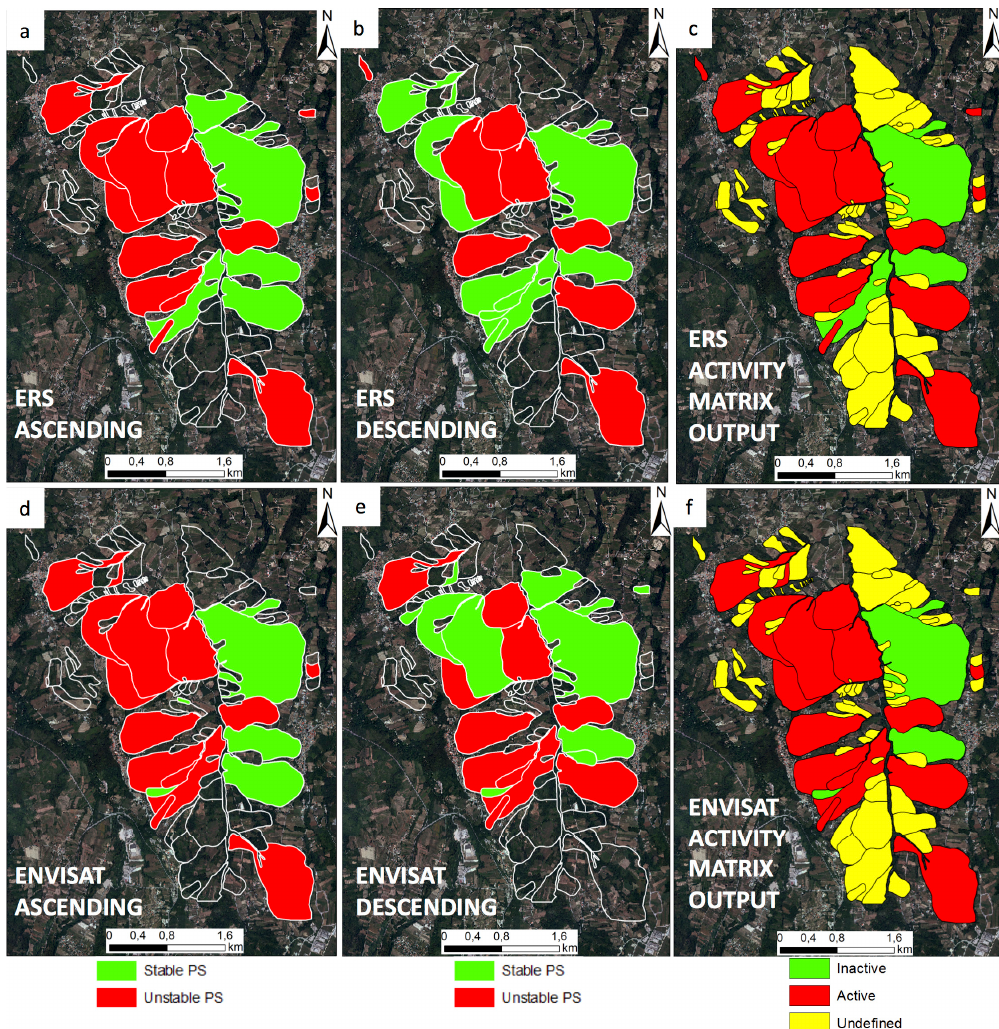
Figure 7. Results from the activity matrix: (a, b, c) ERS (1992-2001) data and (d, e, f) Envisat (2003-2010) data. Green polygons identify presence of stable PSs within the mapped landslide; red polygons identify presence of unstable PSs; empty polygons show missing or insufficient PSs. The state of activity results (shown in c, and f) are derived from both orbital geometries combination. Color codes are the same used for the state of activity matrix in Figure 6.